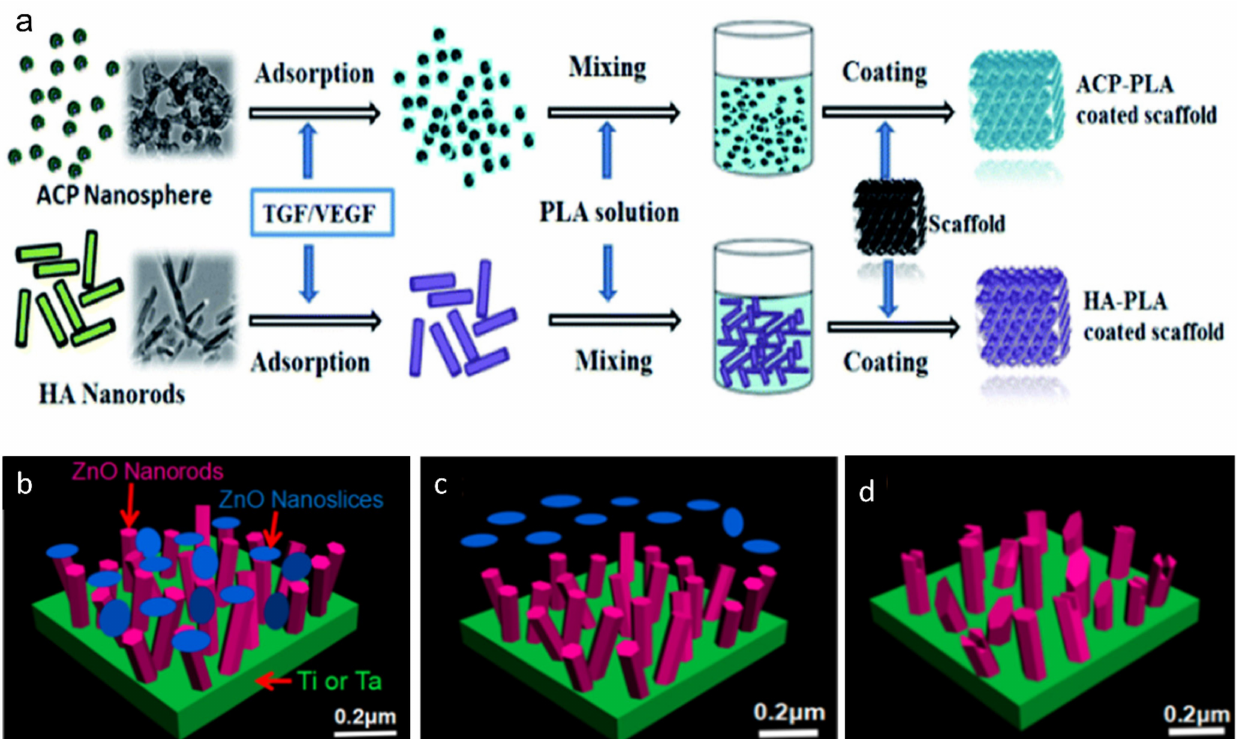
Figure 7. Schematic diagram of the surface modification for porous Ta. Amorphous calcium phosphate (ACP) nanospheres and HA nanorods coating on the surface of Ta scaffold ( a ). Reprinted from ref. [192]. ZnO nanoslices and ZnO nanorods coating on Ta substrate ( b ), the ZnO nanoslices will be released at an early stage—within 48 h ( c ), while the ZnO nanorods are released in a slow pattern over 2 weeks ( d ). Reprinted with permission from [199]. Copyright © 2021 by American Chemical